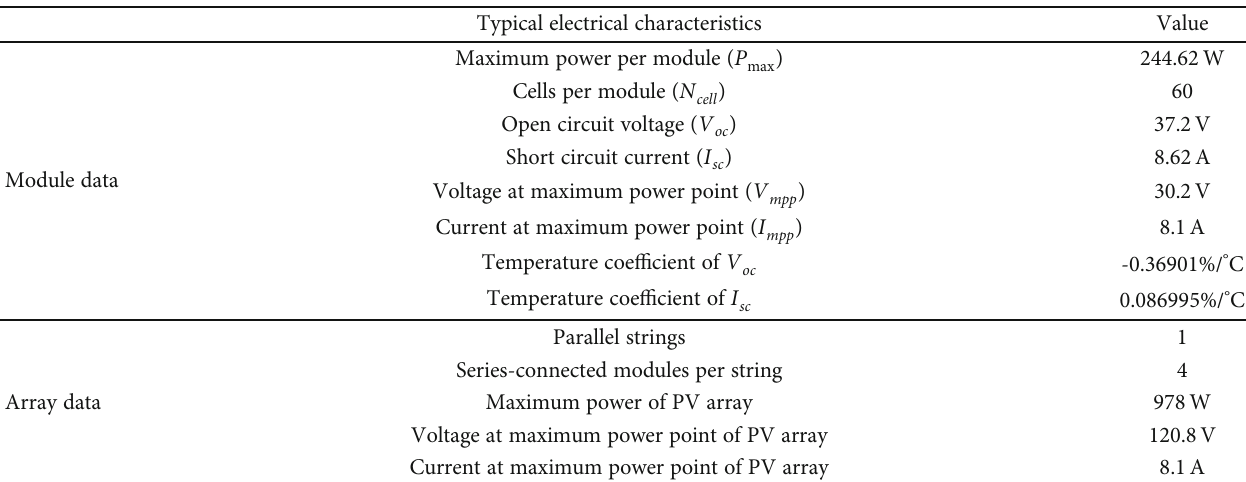
Table 1: Parameters of the PV